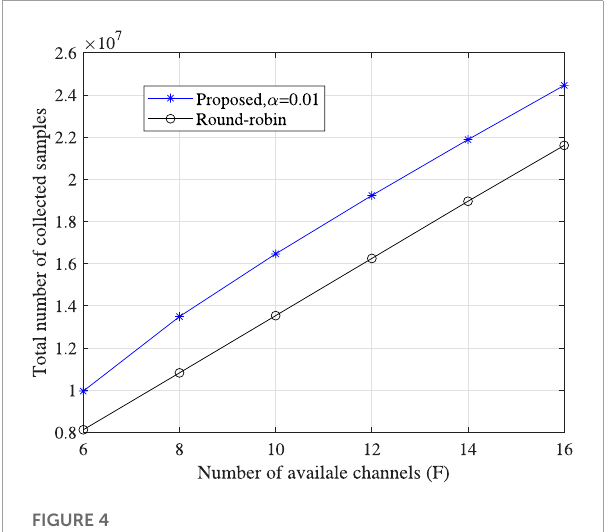
FIGURE 4 Performance comparison of the proposed algorithm with the round-robin